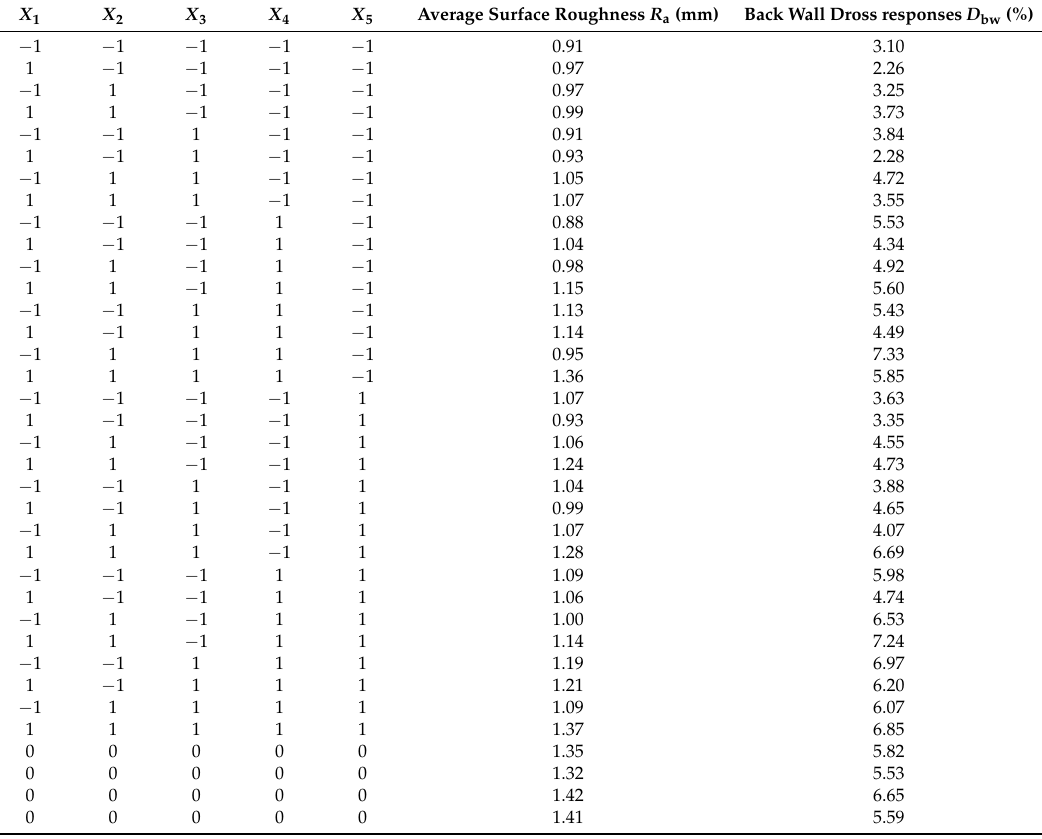
Table A1. Complete data set for miniature tube type A *.